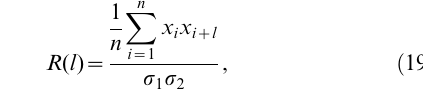
Figure S3 Sample size dependency of the Clauset et al. [14] goodness-of-fit evaluation. A and B. Avalanche size distribution in monkey X for a sub-set with n =1000 and for the whole data set with n =45,548 avalanches, respectively. Shown are the empirical PMFs, P emp ( s ) (gray), and the best-fit power law distributions, P a ( s ) (red). C. Average p -value for different sample sizes in the empirical data (gray line). The gray area indicates the p -values between the 5th and 95th percentile. The p -value for a synthetic power law is uniformly distributed on the interval (0,1) with an average value close to 0.5 (blue line). D–F. The same for the time-shuffled data set and the exponential distribution as the model distribution (green).